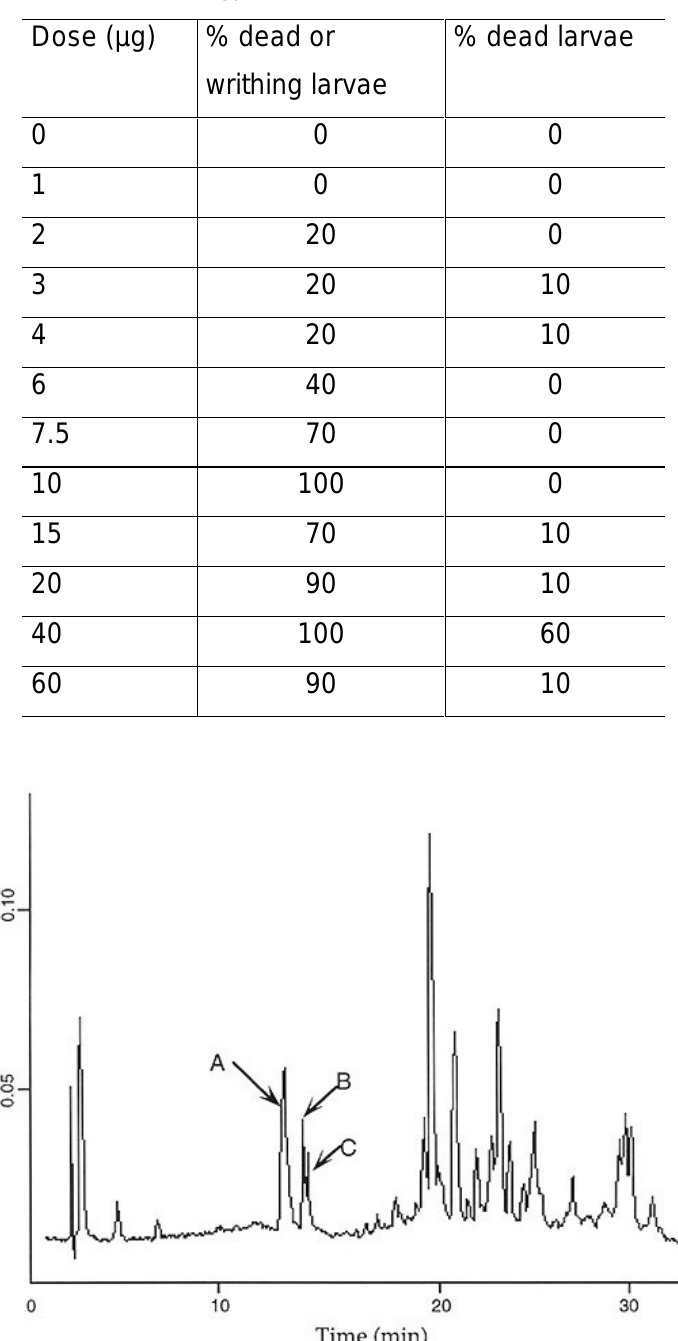
Table 4: Effective toxic dose (ED